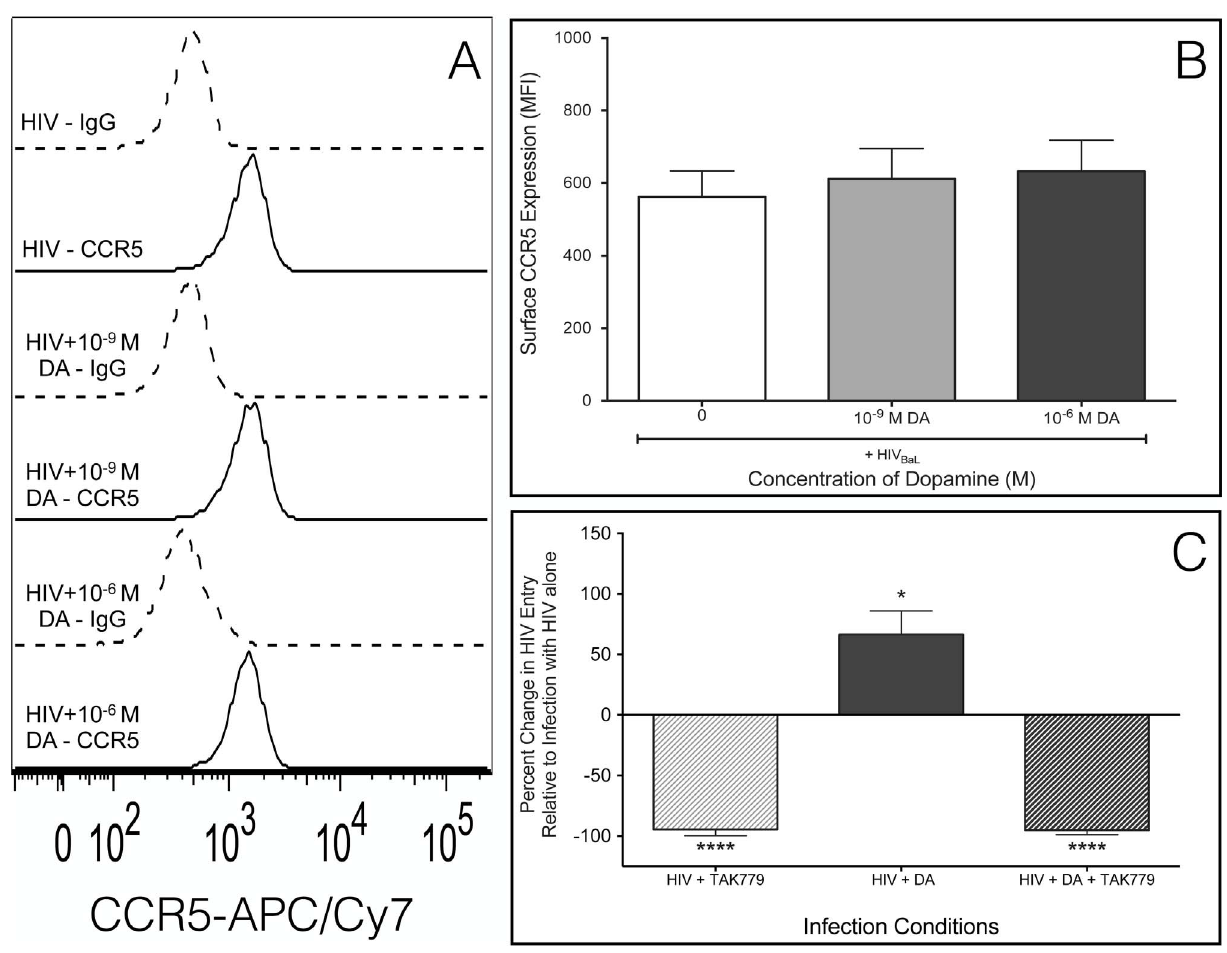
Figure 3. CCR5 is necessary for dopamine-mediated increase in HIV entry. Macrophages were infected with HIV BaL in the presence of 10 9 M or 10 6 M dopamine and analyzed by flow cytometry for CCR5. (A) A representative histogram of CCR5 surface expression in a single donor in response to HIV alone (IgG – dashed grey lines, CCR5 – solid grey lines) is shown. (B) The mean MFI of CCR5 on the surface of macrophages from seven donors infected with HIV alone (white), HIV + 10 9 M DA (light gray) or HIV + 10 6 M DA (dark gray) relative HIV alone. Neither concentration of dopamine-induced significant changes in the expression of this protein on the cell surface relative to the macrophages infected with HIV alone. (C) Macrophages were pretreated with 2 6 10 7 M TAK779, and then an MOI of 0.01 b -lac HIV was added in the presence or absence of 10 8 M dopamine. As controls, both macrophages pretreated with TAK779 and macrophages not pretreated were infected with HIV alone. Dopamine significantly increased HIV entry (n=6, p=0.0194 *), and pretreatment with 2 6 10 7 M of the CCR5 inhibitor TAK779 blocked HIV entry into macrophages infected in both the presence and absence of dopamine (HIV + TAK779, p=0.0001 **, HIV + TAK779 + DA, p=0.0003 ***).